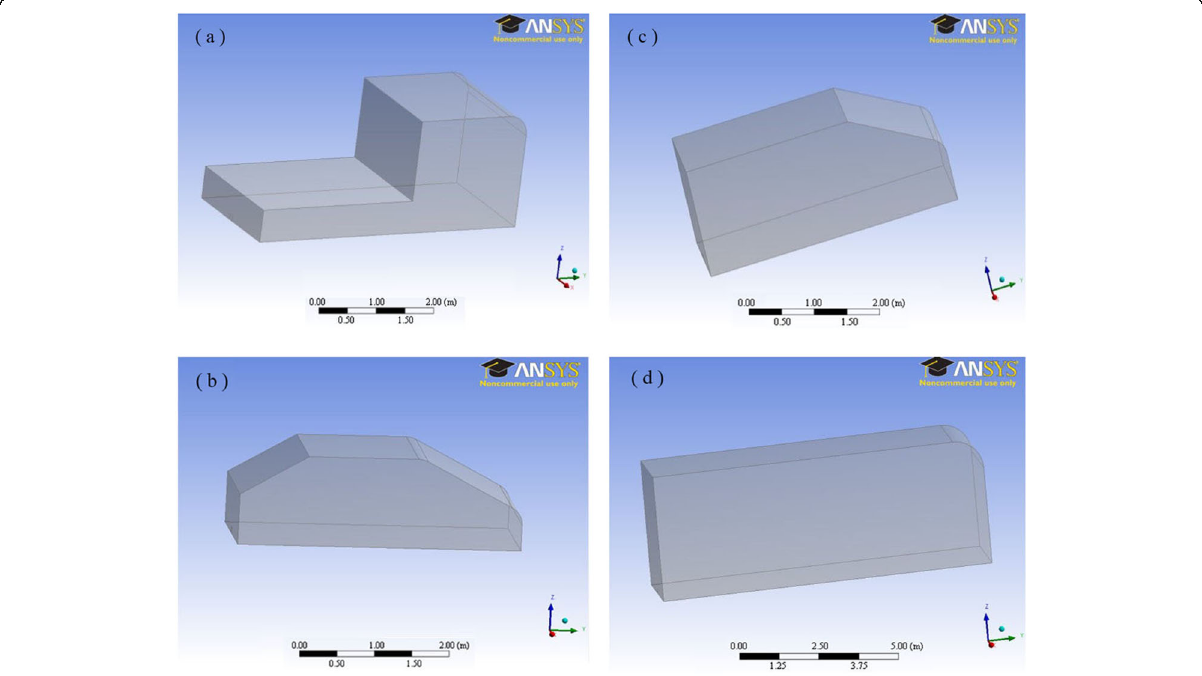
Fig. 2 Geometry of vehicles ( a ) small truck; b sedan; c van; d